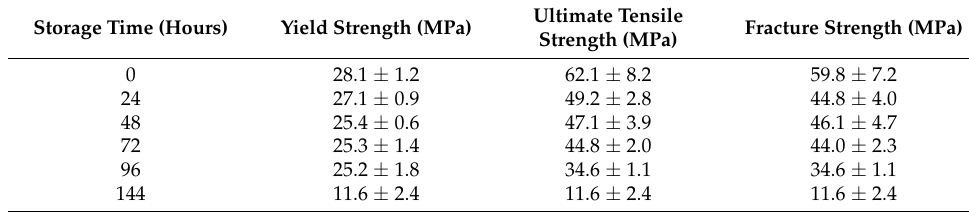
Figure 9. Stress–strain curves for PA-12 tensile samples as a function of storage time. Table 2. The variation of mechanical properties with storage time.